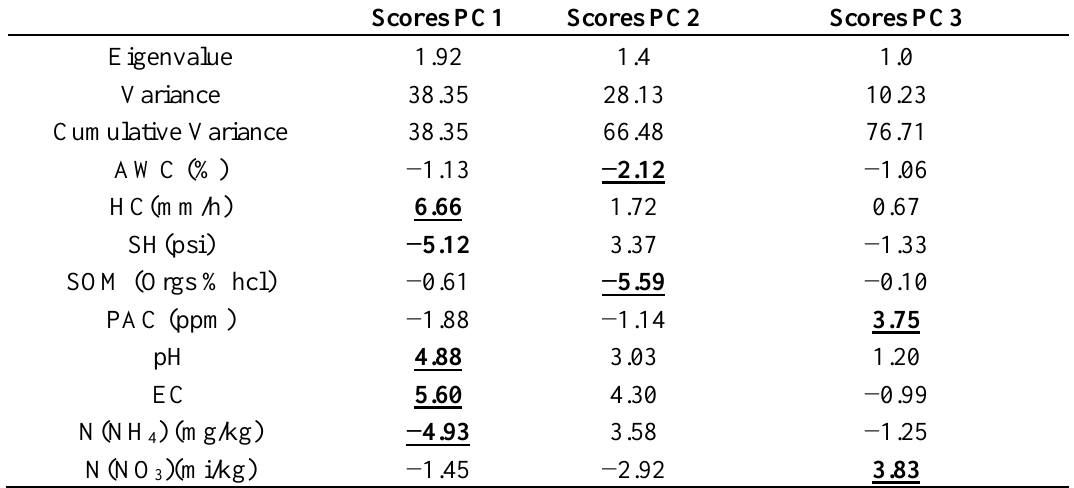
Table 5. Results of the principal component analysis (PCA) of soil properties in the Migda site, Israel. Bold and underlined values indicate underlined factors corresponding to the indicators included in the indices. Scores PC1 Scores PC2 Scores PC3 Eigenvalue 1.92 1.4 1.0 Variance 38.35 28.13 10.23 Cumulative Variance 38.35 66.48 76.71